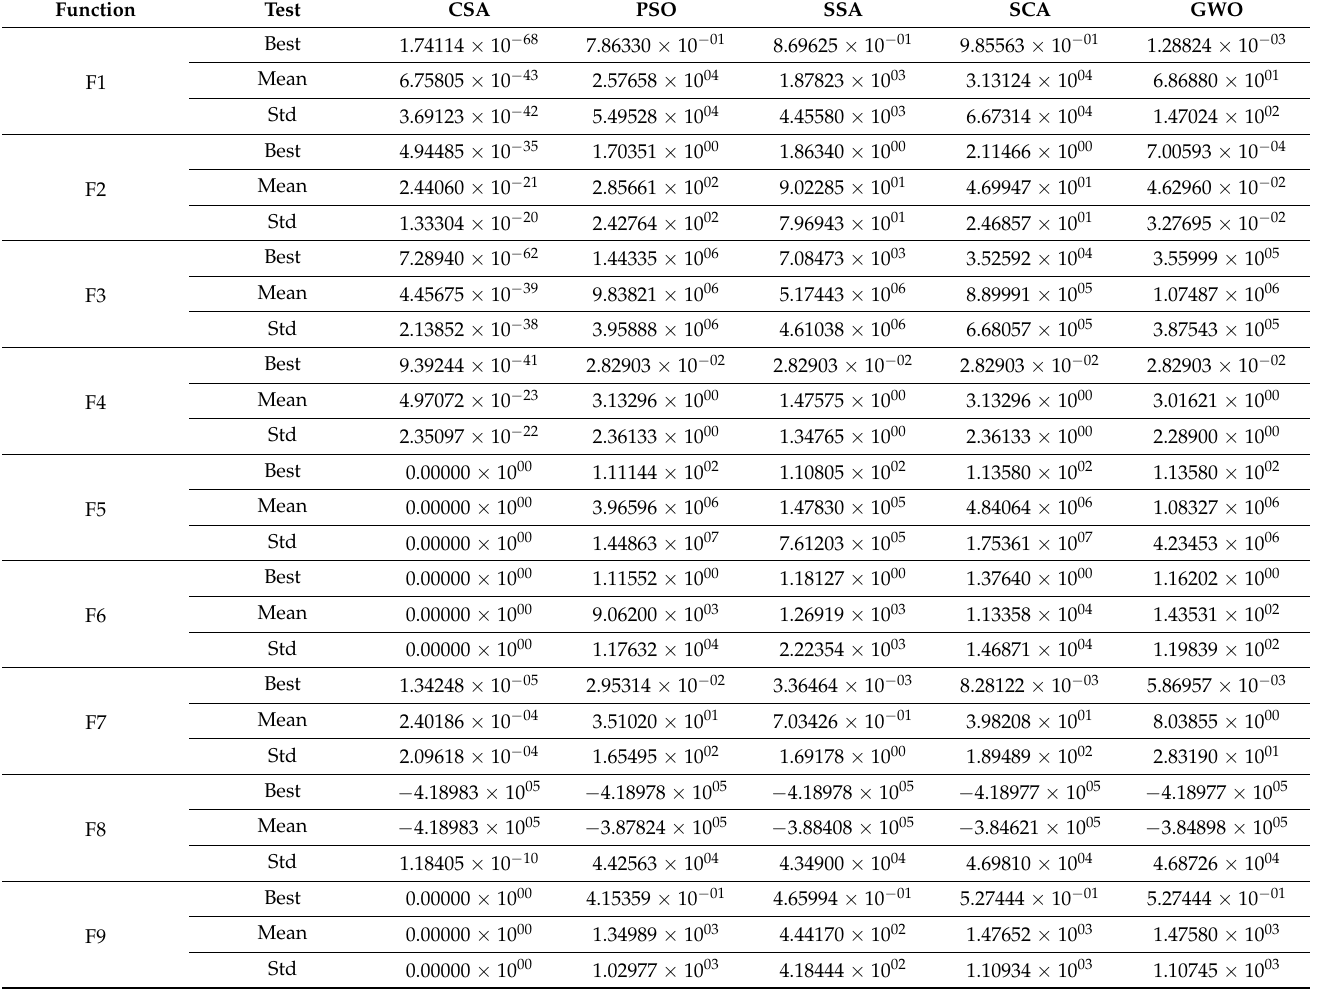
Table 9. Statistical results of the optimized standard functions with d =